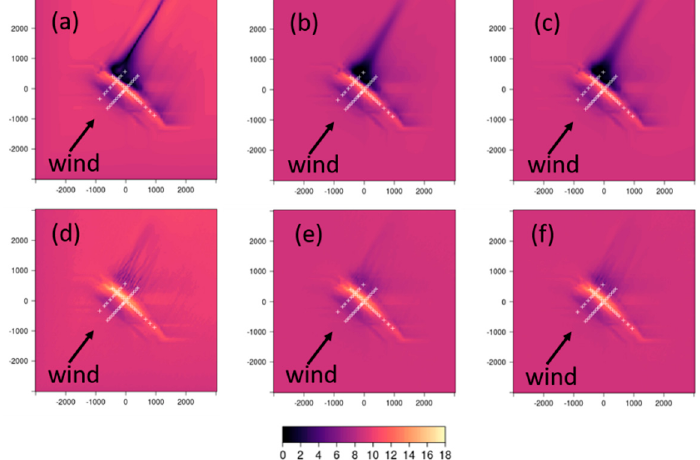
Figure 7. CFD-predicted wind speeds in m s − 1 at 10 m above ground level over Askervein Hill using ( a ) myKELU; ( b ) KELU; ( c ) RNGKELU; ( d ) myKEQUICK; ( e ) KEQUICK; ( f ) RNGKEQUICK. White crosses indicate measurement locations. Black arrows denote the prevailing wind direction. Axes labels are in